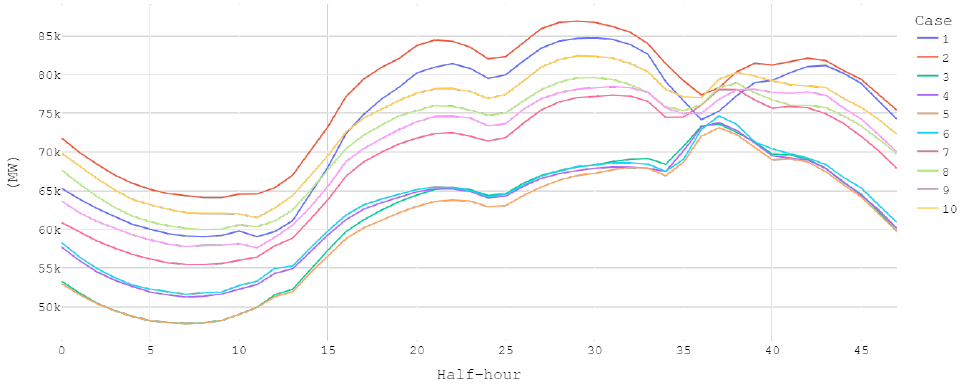
Figure 4. Gross load in each